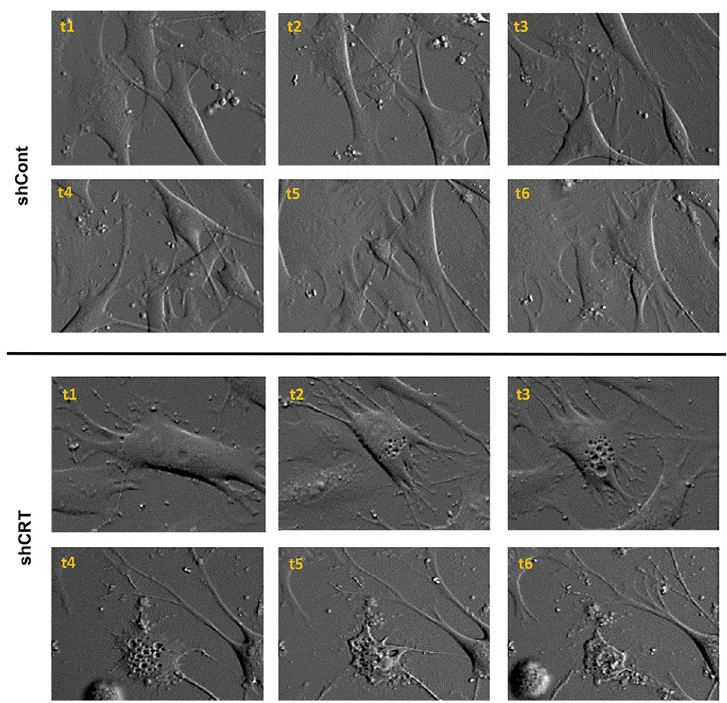
Fig 4. CRT loss initiates nonapoptotic cell-death response leading to the complete cell disintegration. Morphological changes occurring in shCRT and shCont transduced melanoma cells M727 over the period of 72 hours. Bright field image sequence (t1–t6) was taken using 20 × objective of the Olympus VivaView FL motorized inverted microscope integrated into TC chamber. CRT, calreticulin; shCont, short hairpin RNA targeting Control; shCRT, short hairpin RNA targeting Calreticulin; TC, tissue